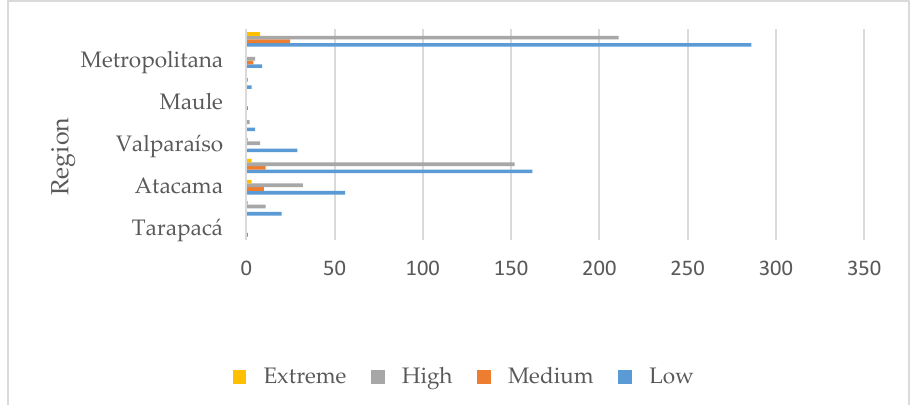
Figure 6. Regional distribution of tailings assessed according to heavy metals and closeness to populated areas.